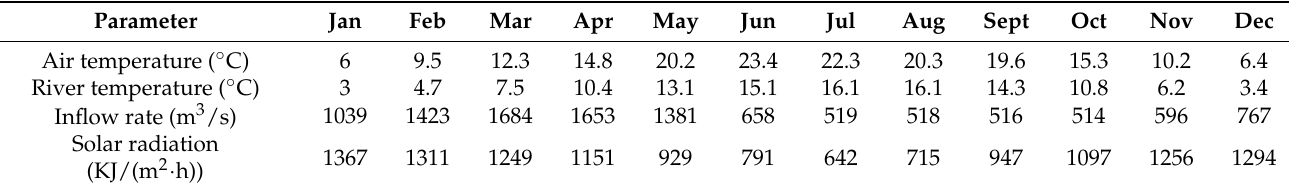
Table 2. Meteorological and hydrological data.